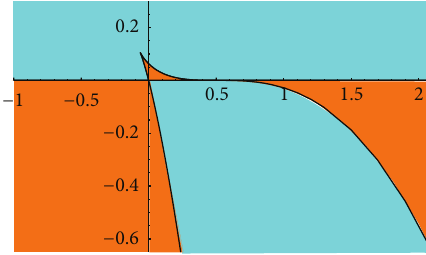
Figure 1: The curves 𝐶 − and 𝐶 + .